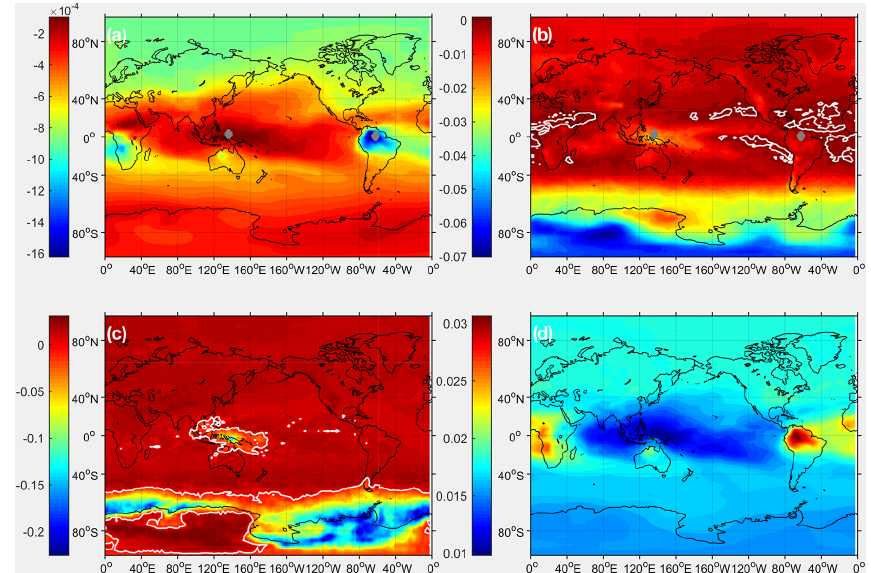
Figure 5. Annually averaged accumulation-mode dust number sensitivities for (a) PDA08, (b) PDA13, (c) CNT and (d)